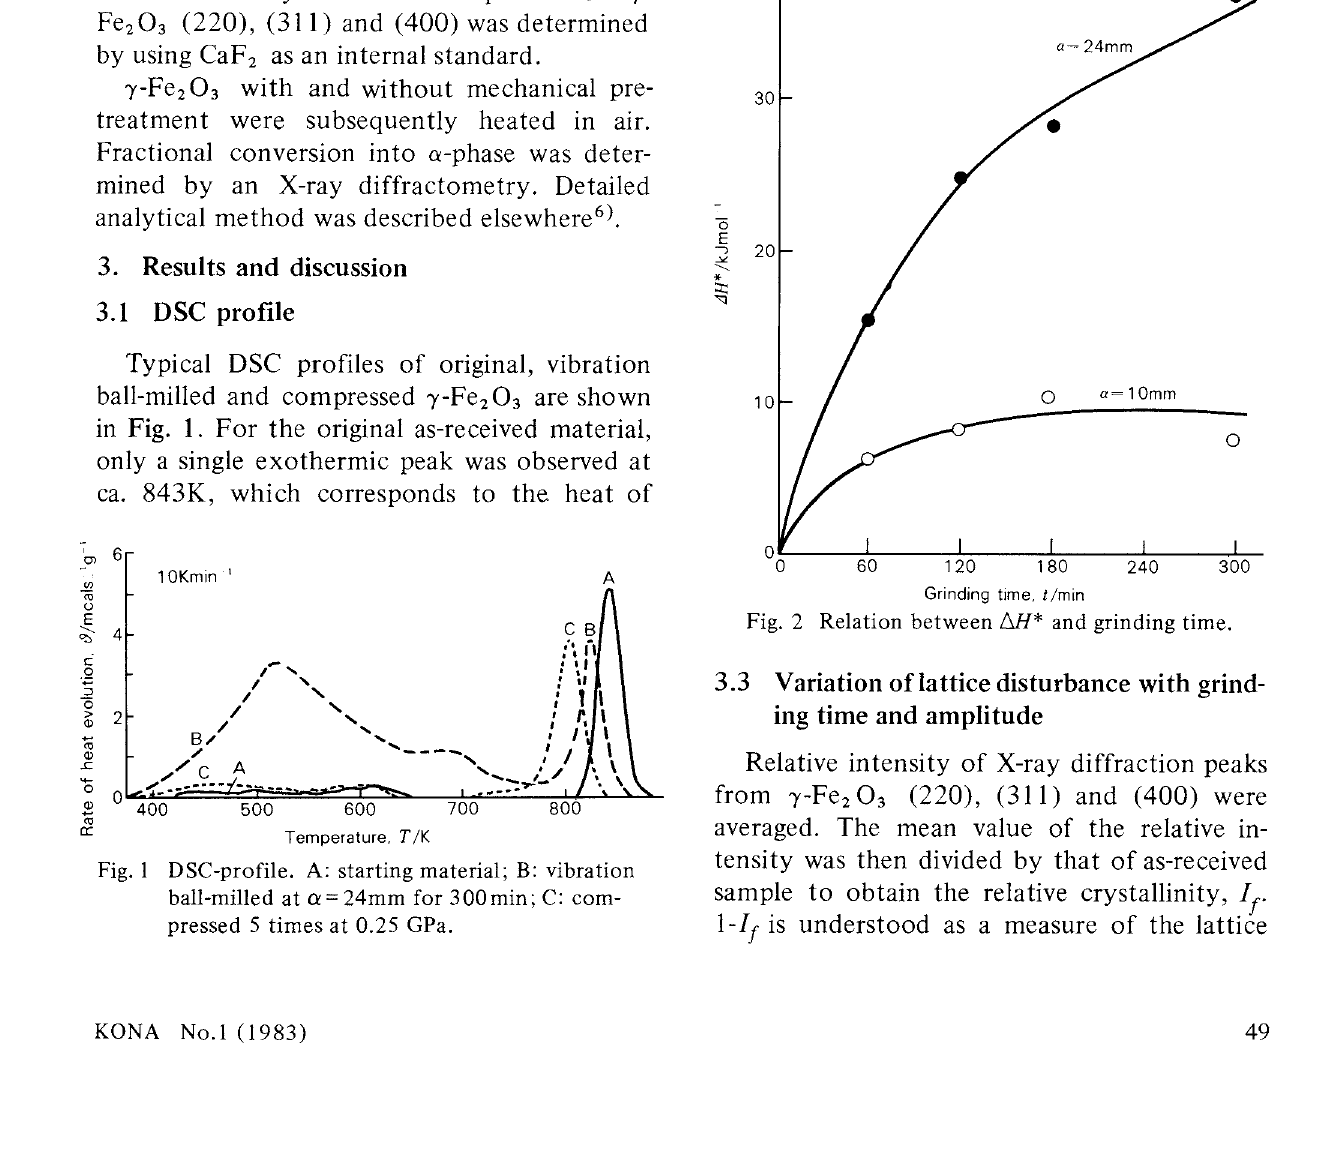
Fig. I DSC-profile. A: starting material; B: vibration ball-milled at a=24mm for 300min; C: com pressed 5 times at 0.25 GPa.